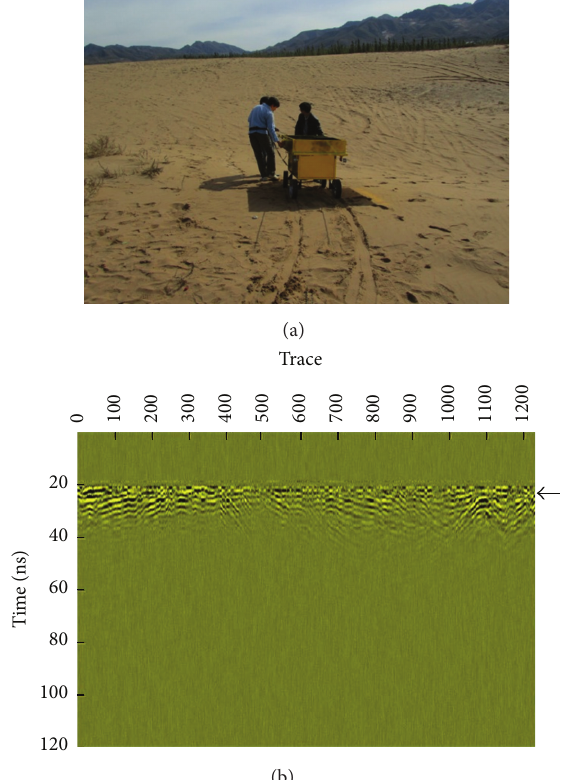
Figure 10: Experiment: (a) experiment scene; (b) radar profiles of